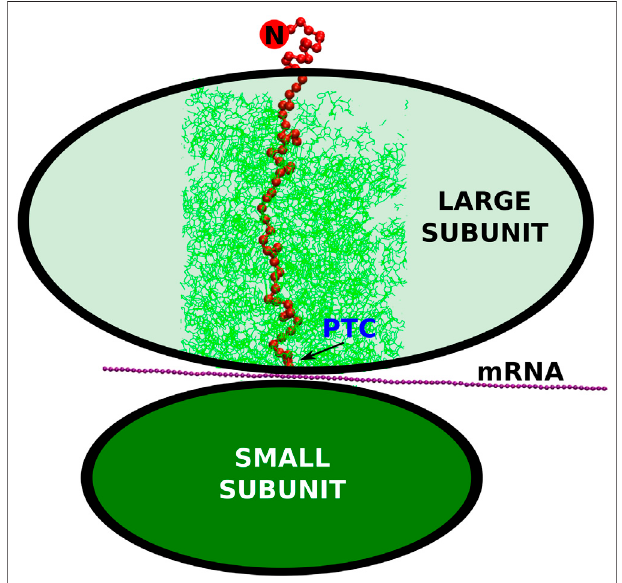
FIGURE 1 | The schematic representation of the small and large ribosomal subunits (the green ovals). The arrow points to the peptidyl- transferase center where the conversion of the nucleic acid genetic information (mRNA) into the polypeptide (the red string) takes place. The cylindrical cut-out, considered in our simulations, is marked by the thin, green lines. The N-terminus of the synthesized protein is marked by the red circle with the letter “ N ” .